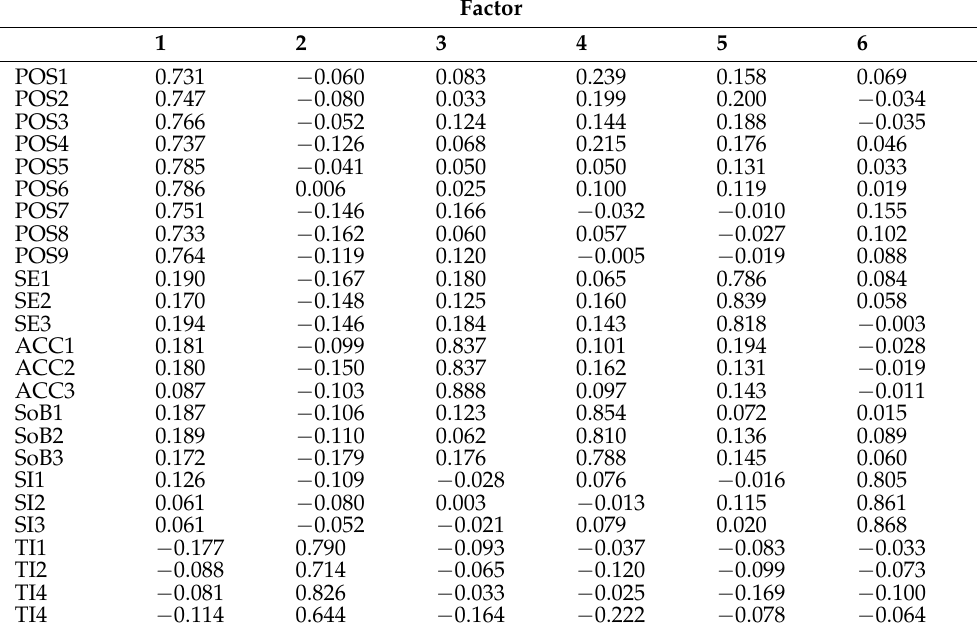
Table 4. Factor analysis (rotated factor